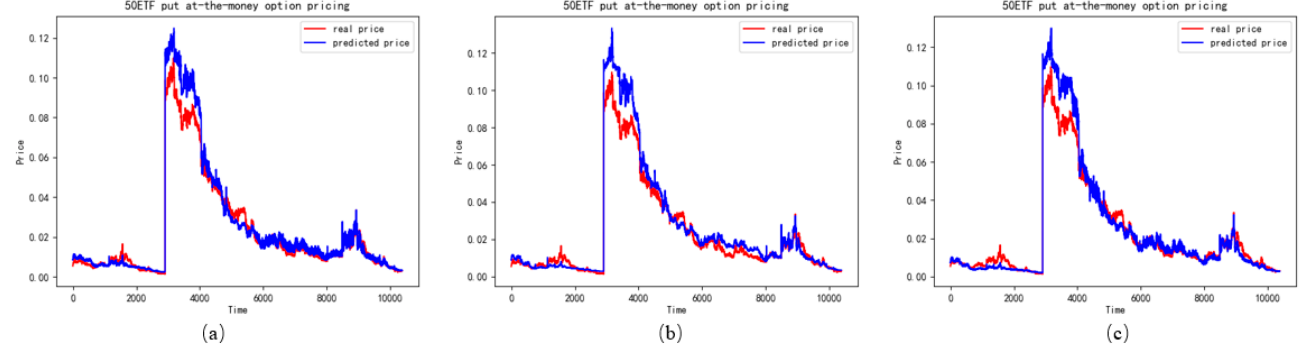
Figure 10. The performance of ITM put options in different features ( a ) represents the LSTM with realized skewness, ( b ) represents the LSTM without realized skewness, ( c ) represents the LSTM with realized skewness and realized kurtosis.